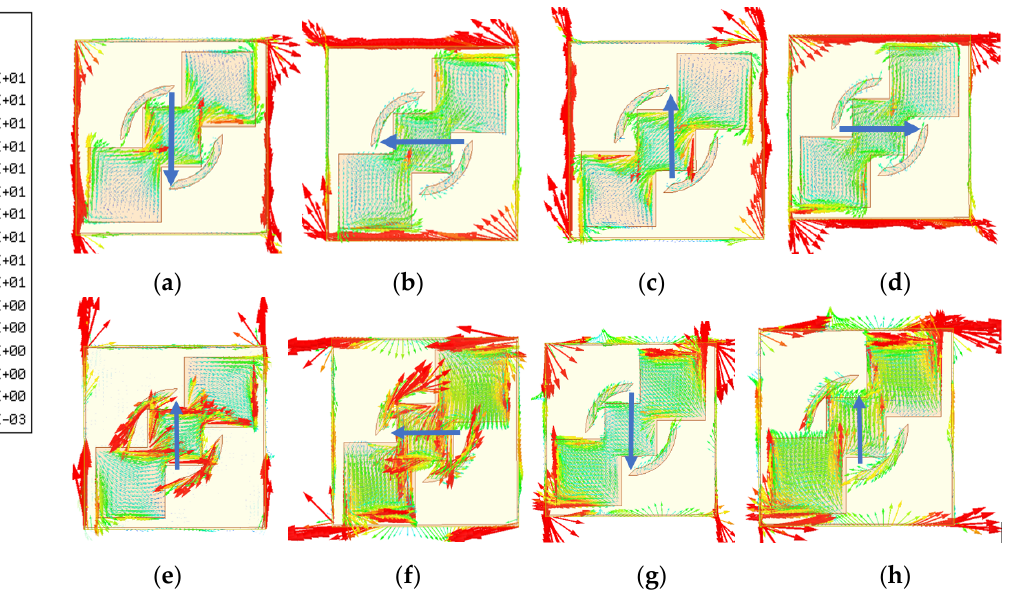
Figure 4. Surface current phenomenon in the proposed structure at 13.58 GHz: ( a ) t = 0, ( b ) t = T/4, ( c ) t = T/2, ( d ) t = 3T/4; and at 40 GHz: ( e ) t = 0, ( f ) t = T/4, ( g ) t = T/2, ( h ) t = 3T/4 .